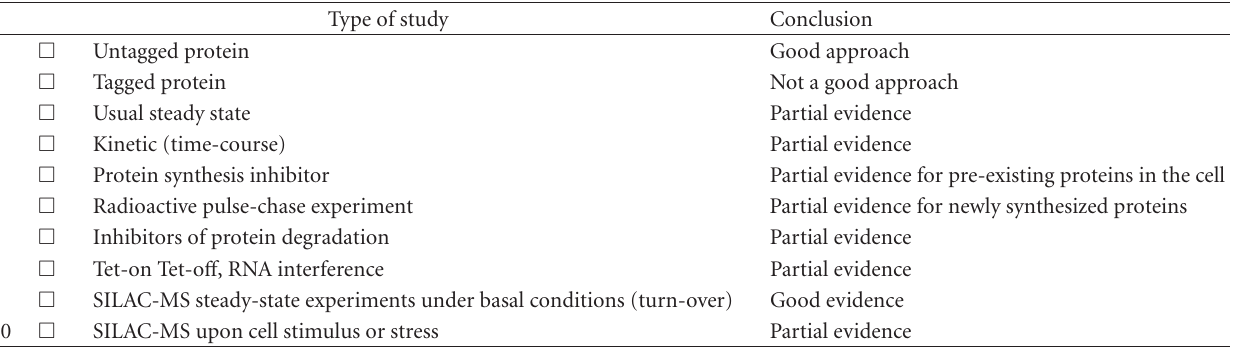
Type of study Conclusion